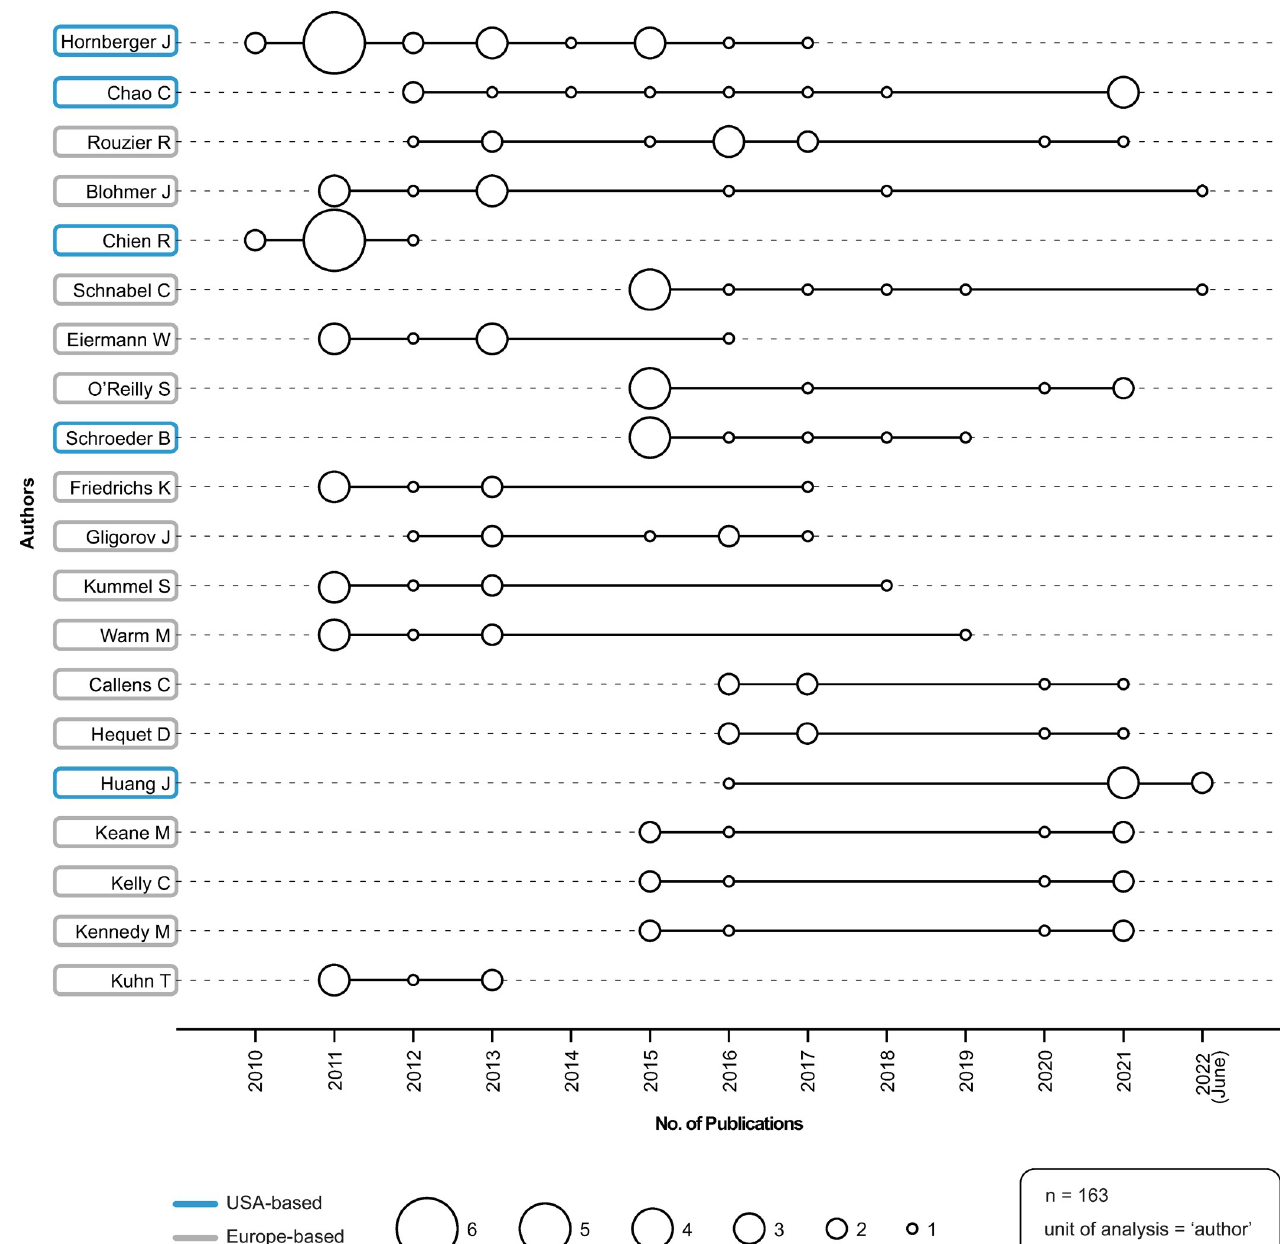
Fig 4. Top 20 author production over time. Source: R-based application Biblioshiny was used; additional analysis (i.e., affiliate region of origin) was completed by the study authors and applied to the visualization using Adobe Illustrator. Parameters specified: number of authors = 20.